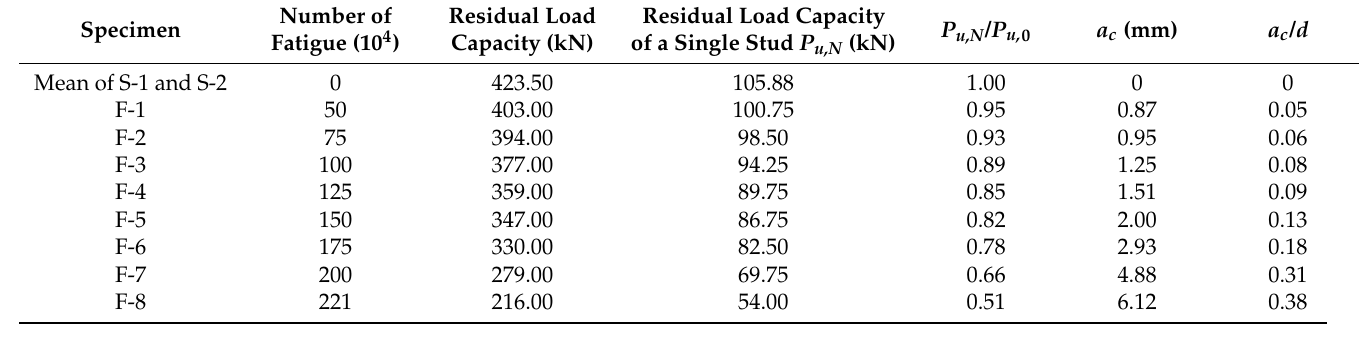
Table 6. Residual bearing capacity and fatigue crack depth of specimens under different cyclic loads.